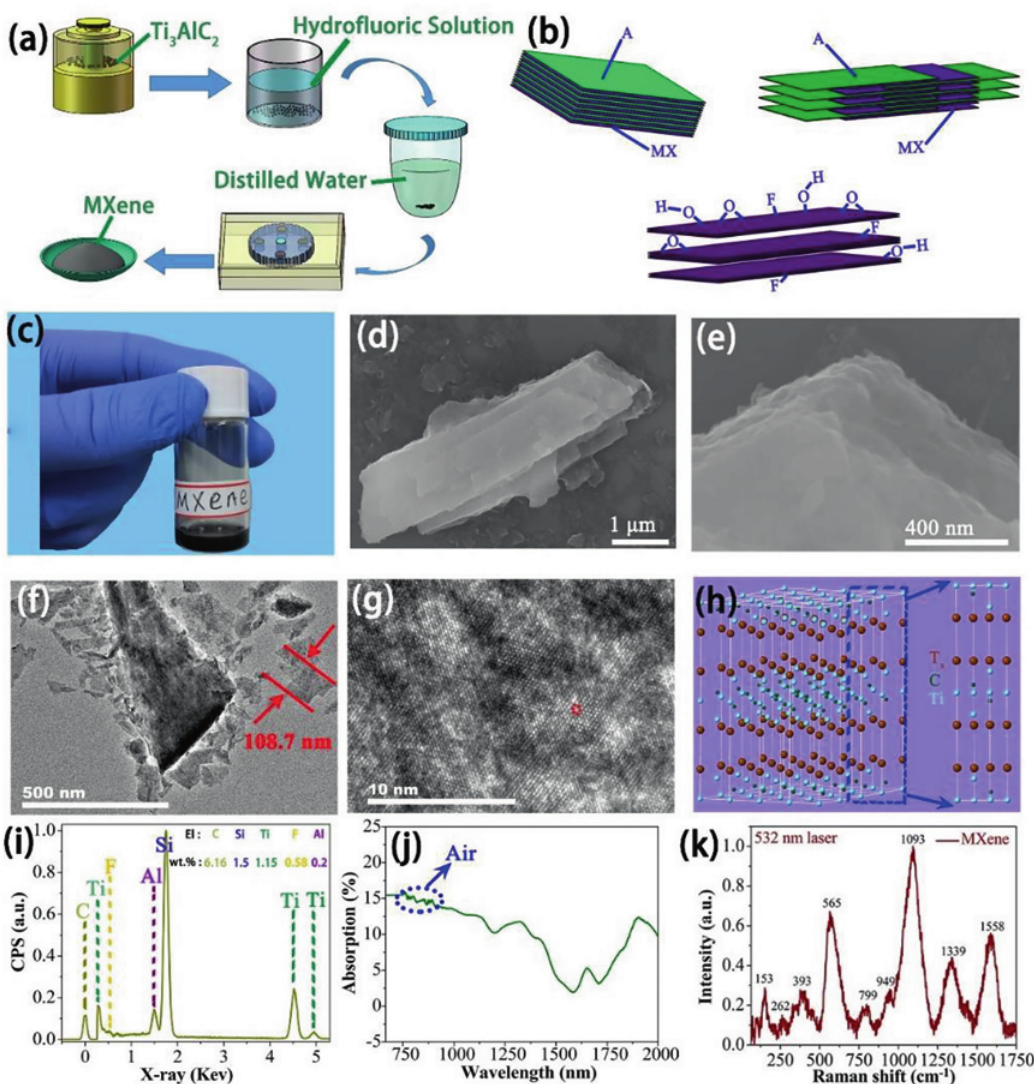
Figure 1: (a) Preparation of MXene flow chart. (b) Schematic of the exfoliation process for Ti 3 AlC 2 . (c) Photograph of the MXene dispersion liquid (d) SEM image with scale of 1 μ m. (e) SEM image with scale of 400 nm. (f) TEM image with 500 nm. (g) HRTEM image with 10 nm. (h) The atomic layers ’ structure of MXene. (i) EDS spectrum. (j) Absorption spectrum. (k) Raman